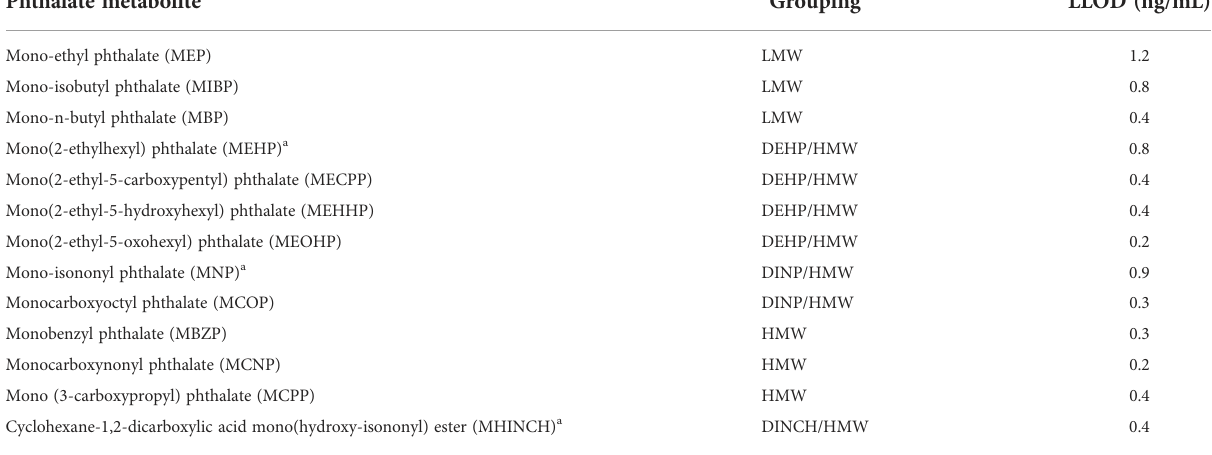
TABLE 2 Phthalate metabolites measured in NHANES, 2013-2016.